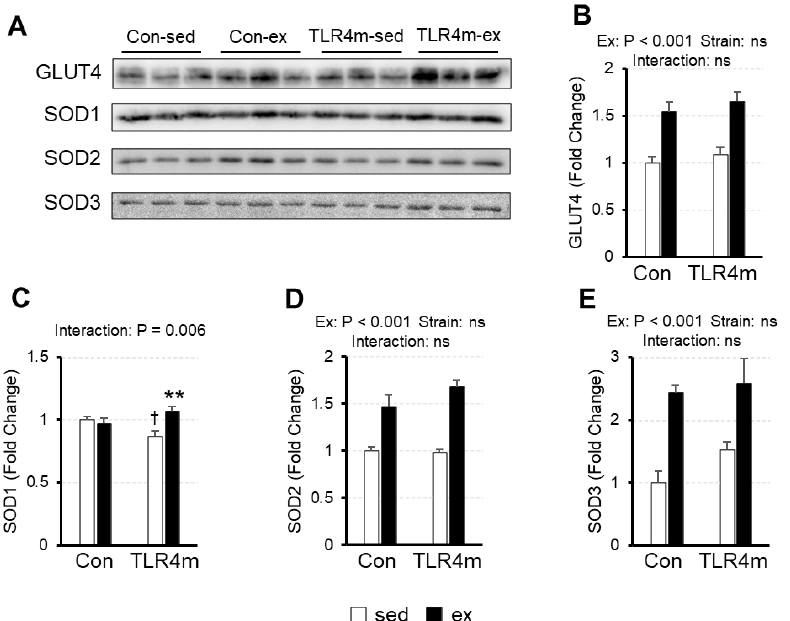
Figure 4. The relative expressions of molecules related to mitochondrial biogenesis in the plantaris. Peroxisome proliferator-activated receptor gamma co-activator 1-alpha (PGC-1 α ) ( B ), peroxisome proliferator-activated receptor beta (PPAR β ) ( C ), heat shock protein 72 (HSP72) ( D ), transcription factor EB (TFEB) ( E ), and cellular repressor of E1A-stimulated genes 1 (CREG1) ( F ) were measured. Representative images of immunoblots are shown ( A ). Values are means ± standard error; n = 6 per group. *** p < 0.001 and ** p < 0.01 vs. sed within each strain; ††† p < 0.001 and †† p < 0.01 vs. controls within each condition.